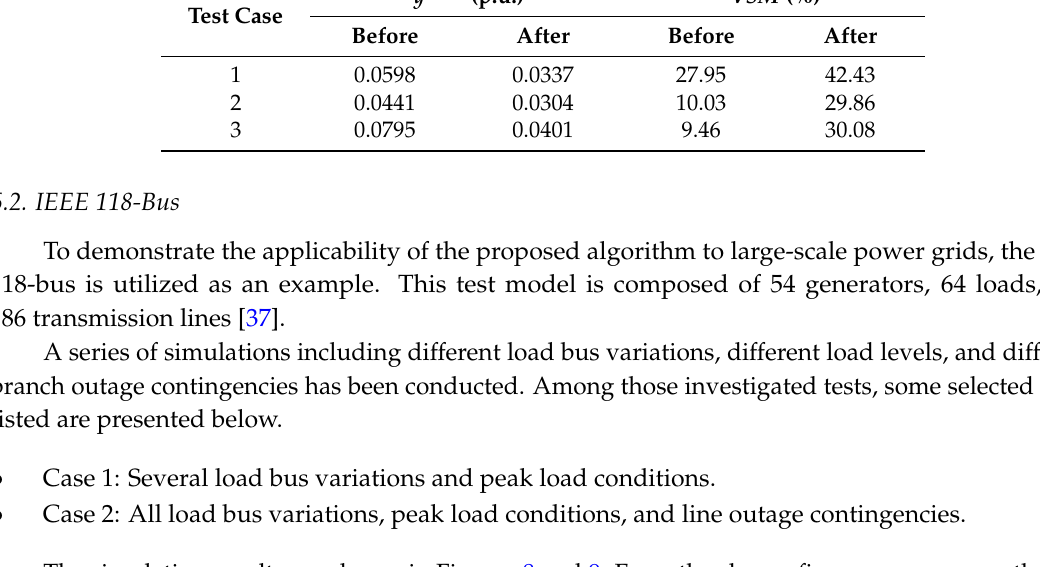
Table 1. Summary of the results for IEEE 9 ‐ bus. VSM , Voltage Stability Margin.